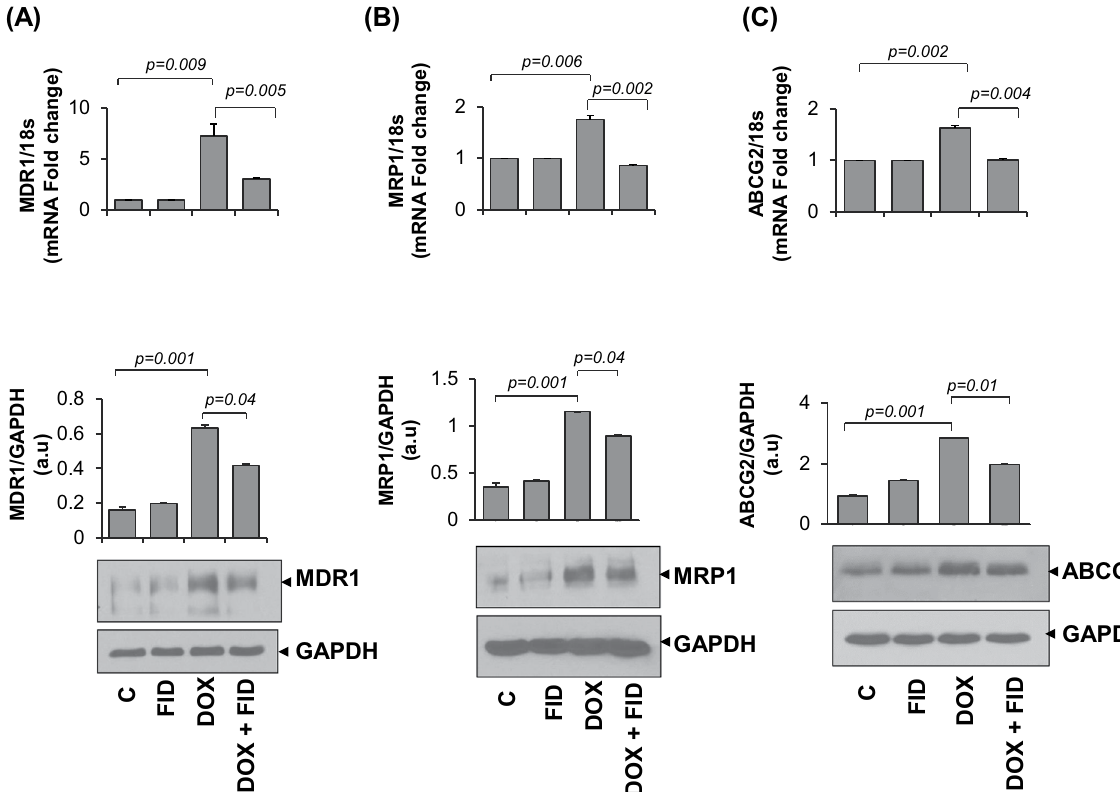
Figure 3. Expression of drug transporters in colon cancer cells: Gene and protein expression levels of drug transporters ( A ) MDR1 ( B ) MRP1 and ( C ) ABCG2 in HT-29 cells after 24 h of treatment with DOX (1 µ M) without or with fidarestat (30 µ M). Histograms showing quantification of blots along with p values mentioned in the figures. (n = 3). The representative cropped blots are shown and the full-length blots are presented in Supplementary Fig.